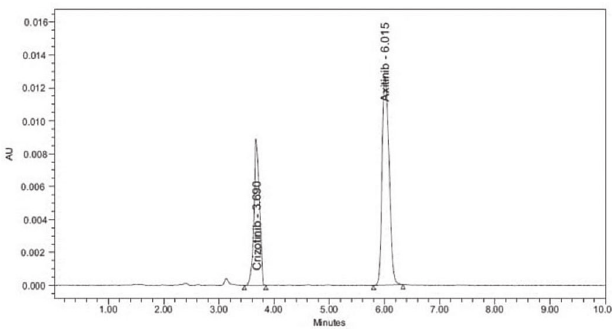
FIGURE 6 - Chromatogram of HQC.